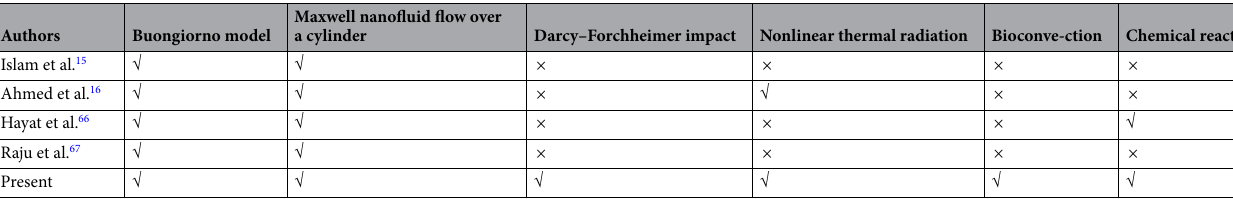
Table 1. A literature analysis for the individuality of the stated model. (√) means said effect present, and ( ×) signifies the impact is absent.